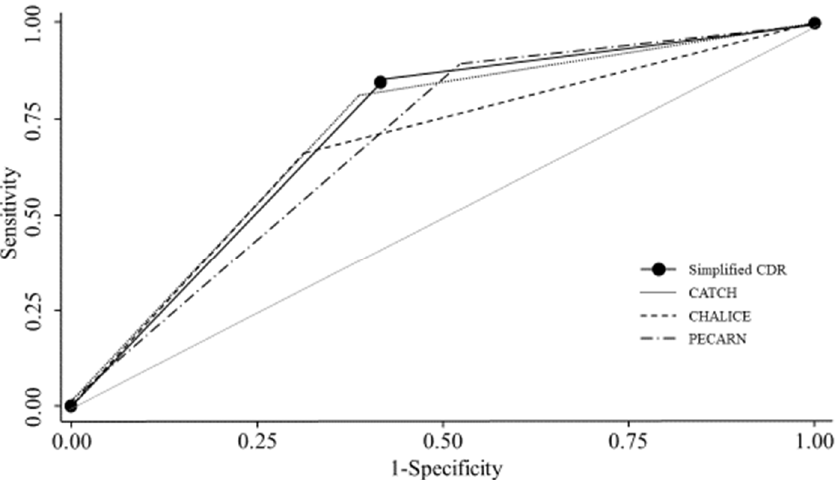
Figure 2. Comparison of our simplified clinical decision rule with CATCH, CHALICE, and